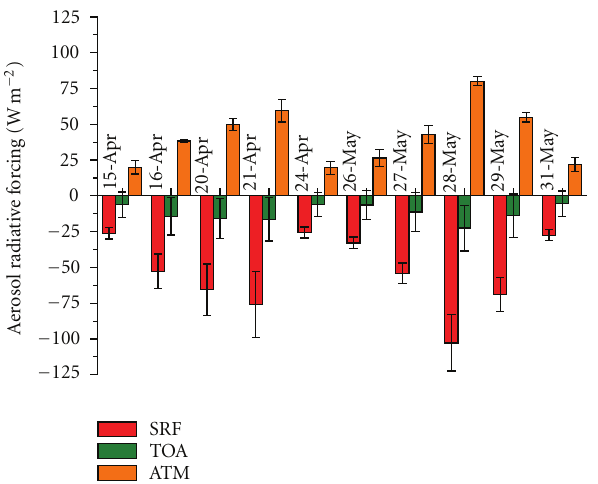
Figure 9: Variation of aerosol radiative forcing values at SRF, TOA and ATM during dusty days over Patiala during the pre-monsoon season of 2010.